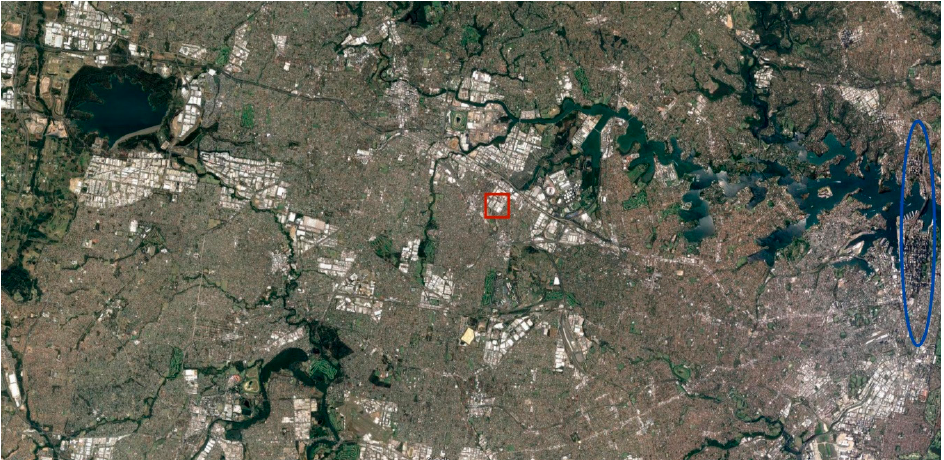
measurement site including the open path Fourier transform infra ‐ red (OP ‐ FTIR) spectrometer